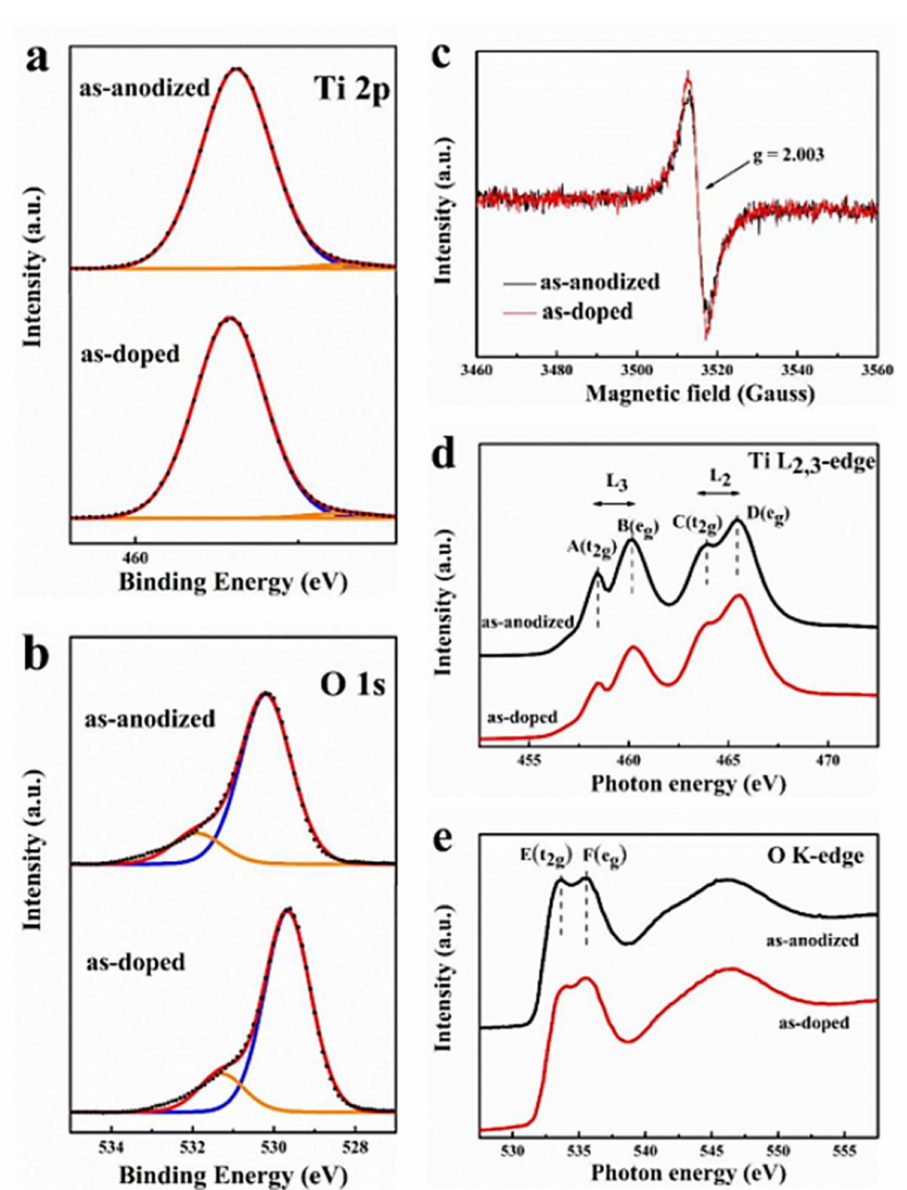
Figure 18. Doped and undoped titanium dioxide nanotubes’ XPS spectra for ( a ) Ti 2p, ( b ) O 1 s, ( c ) EPR, and XANES spectra for ( d ) Ti L2,3-edge XANES and ( e ) O K-edge. Reprinted with permission from Ref. [215]. Copyright 2019